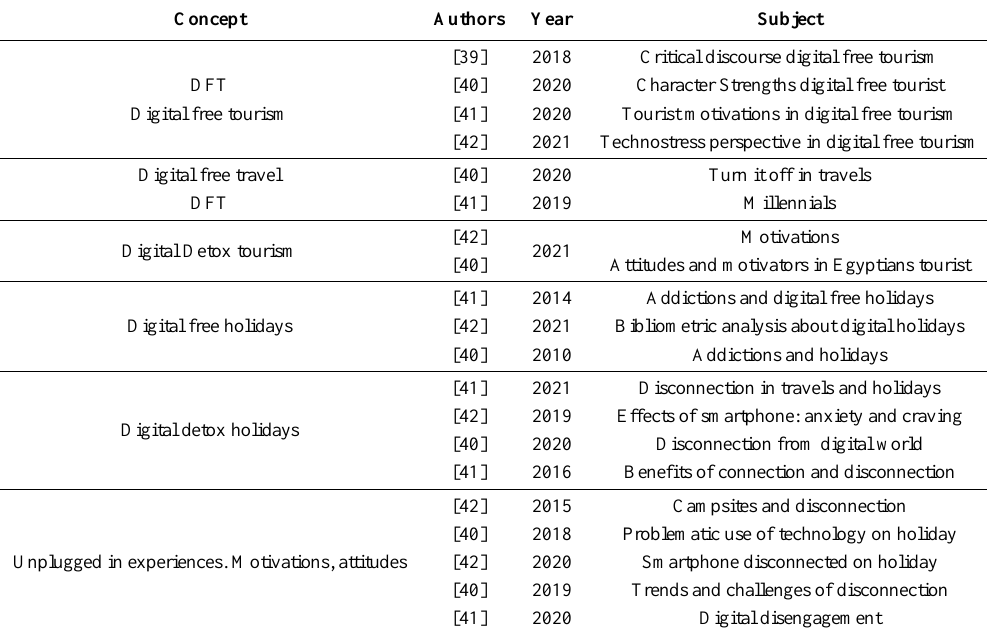
Table 2. Semantic terminology of digital disconnection tourism and the